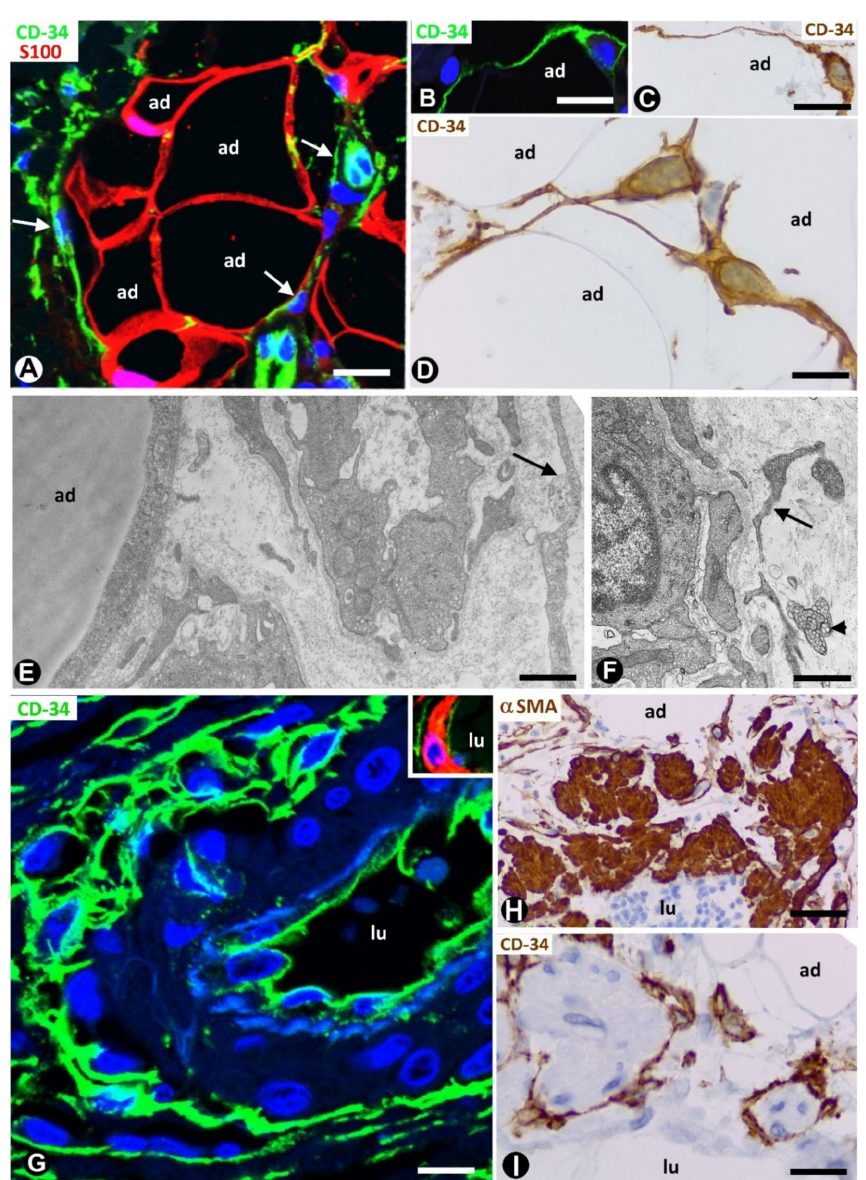
Figure 1. Telocytes / CD34 + stromal cells (TCs / CD34 + SCs) in the normal adipose tissue. ( A ): TCs / CD34 + SCs (green, arrows) in a septum and in a lobular region, in which adipocytes (ad) express S100 protein (red). ( B – D ): TCs / CD34 + SCs (green in ( B ), and brown in ( C , D ) with small somatic bodies and long, thin processes between adipocytes (ad). ( E , F ): telopodes of telocytes (arrows) are ultrastructurally observed around small vessels. Note in F an extracellular multivesicular body (arrowhead) next to the telopodes. G and insert: a large septal vessel showing a double-ring appearance with anti-CD34 staining (green). Note that CD34 stained ECs in the intima and TCs / CD34 + SCs in the adventitia form two stained circles “sandwiching” the unstained ( G ) or red α SMA stained (Insert) media layer. ( H , I ): lymphatic collectors in which parietal smooth muscle cells (expressing α SMA, ( H )) are surrounded by TCs / CD34 + SCs ( I ). Lumen = lu in blood ( G ) and lymphatic ( H , I ) vessels. A: double immunofluorescence labelling for CD34 (green) and protein S100 (red). B and G: immunofluorescence labelling for CD34 (green). ( C , D , I ): immunochemistry for CD34. E and F: ultrathin sections. Uranyl acetate and lead citrate. Insert of G: double immunofluorescence staining for CD34 (green) and α SMA (red). H: immunochemistry for α SMA(brown). DAPI(4 (cid:48) ,6-diamidino-2-phenylindole)(blue)counterstainfor nuclei in A, B, G and insert of G, and haematoxylin counterstain in ( C , D , H , I ). Bar: ( A , H , I ): 50 µ m; ( B , C , G ): 30 µ m; ( D ): 20 µ m; ( E , F ): 4 µ